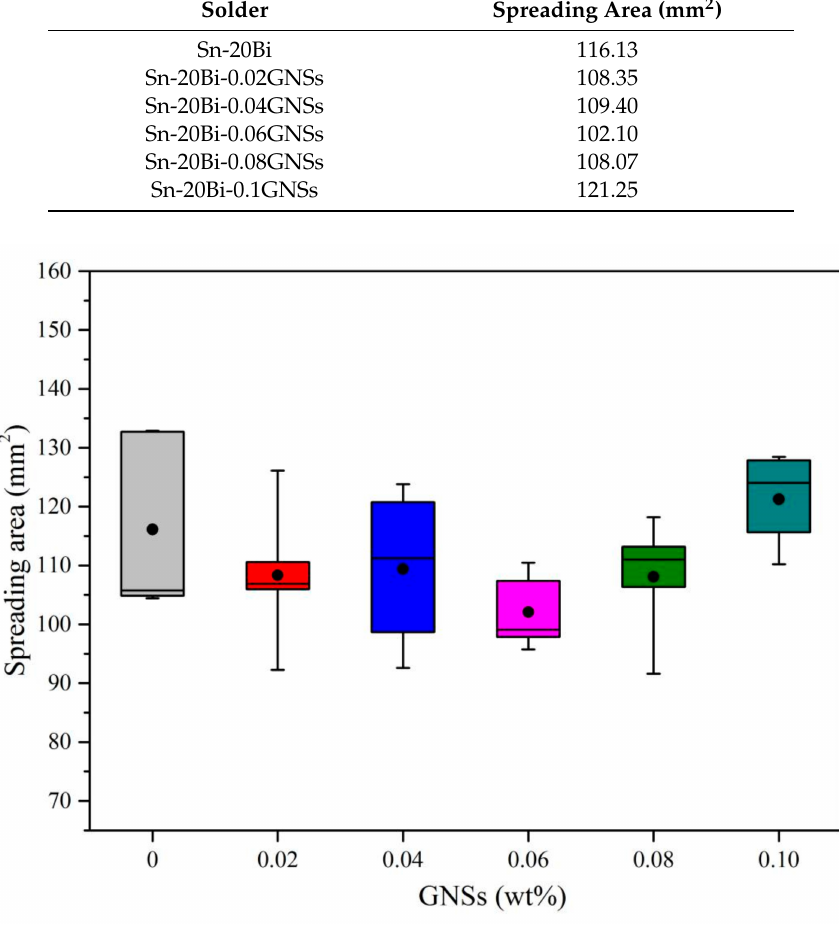
Figure 1. Spreading area of Sn-20Bi-xGNS solder on Cu